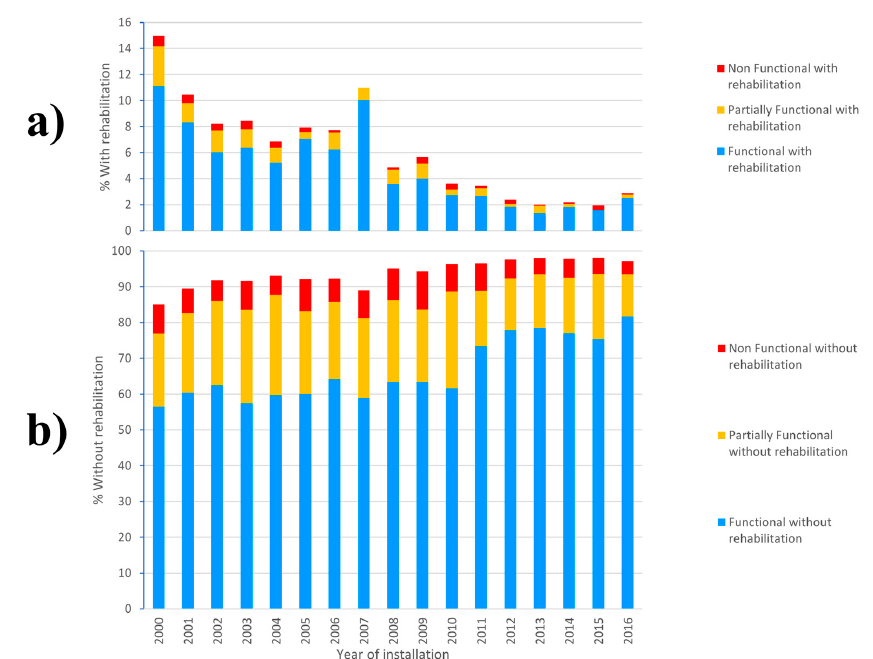
Figure 3. Afridev hand pump borehole functionality distribution across MDG period with service providers (n = 13,281). ( a ) % of data set with rehabilitation conducted during the life cycle; ( b ) % of data set without rehabilitation conducted during the life cycle.